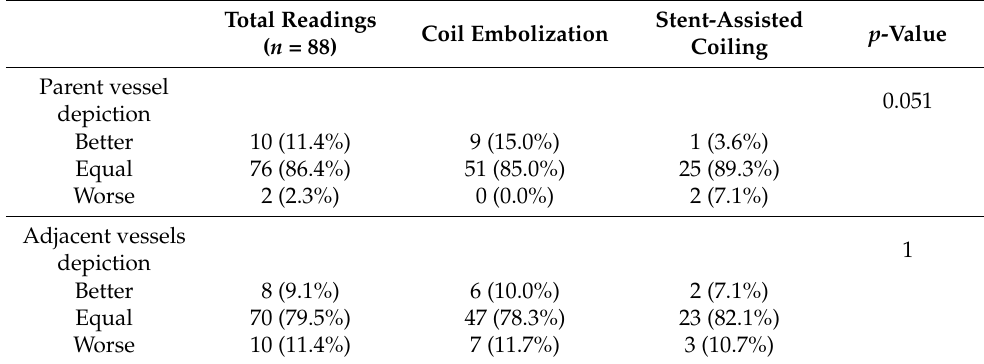
Table 2. Comparison of CS vs PI TOF MRA performance in depicting aneurysm parent vessel and adjacent